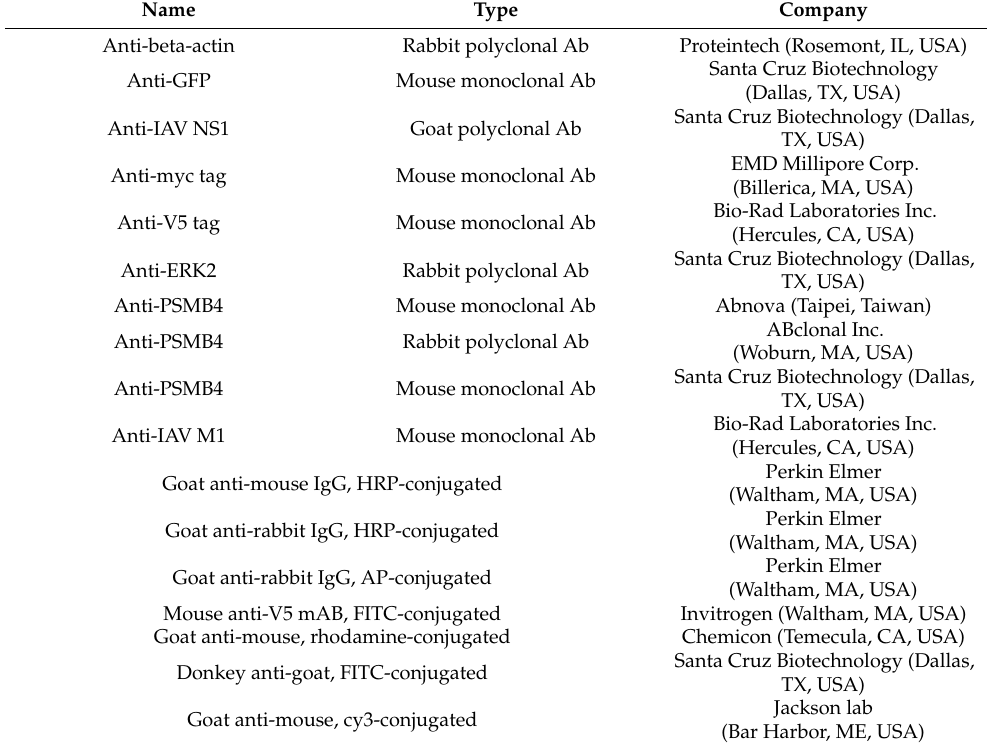
Table 2. Antibodies used in this